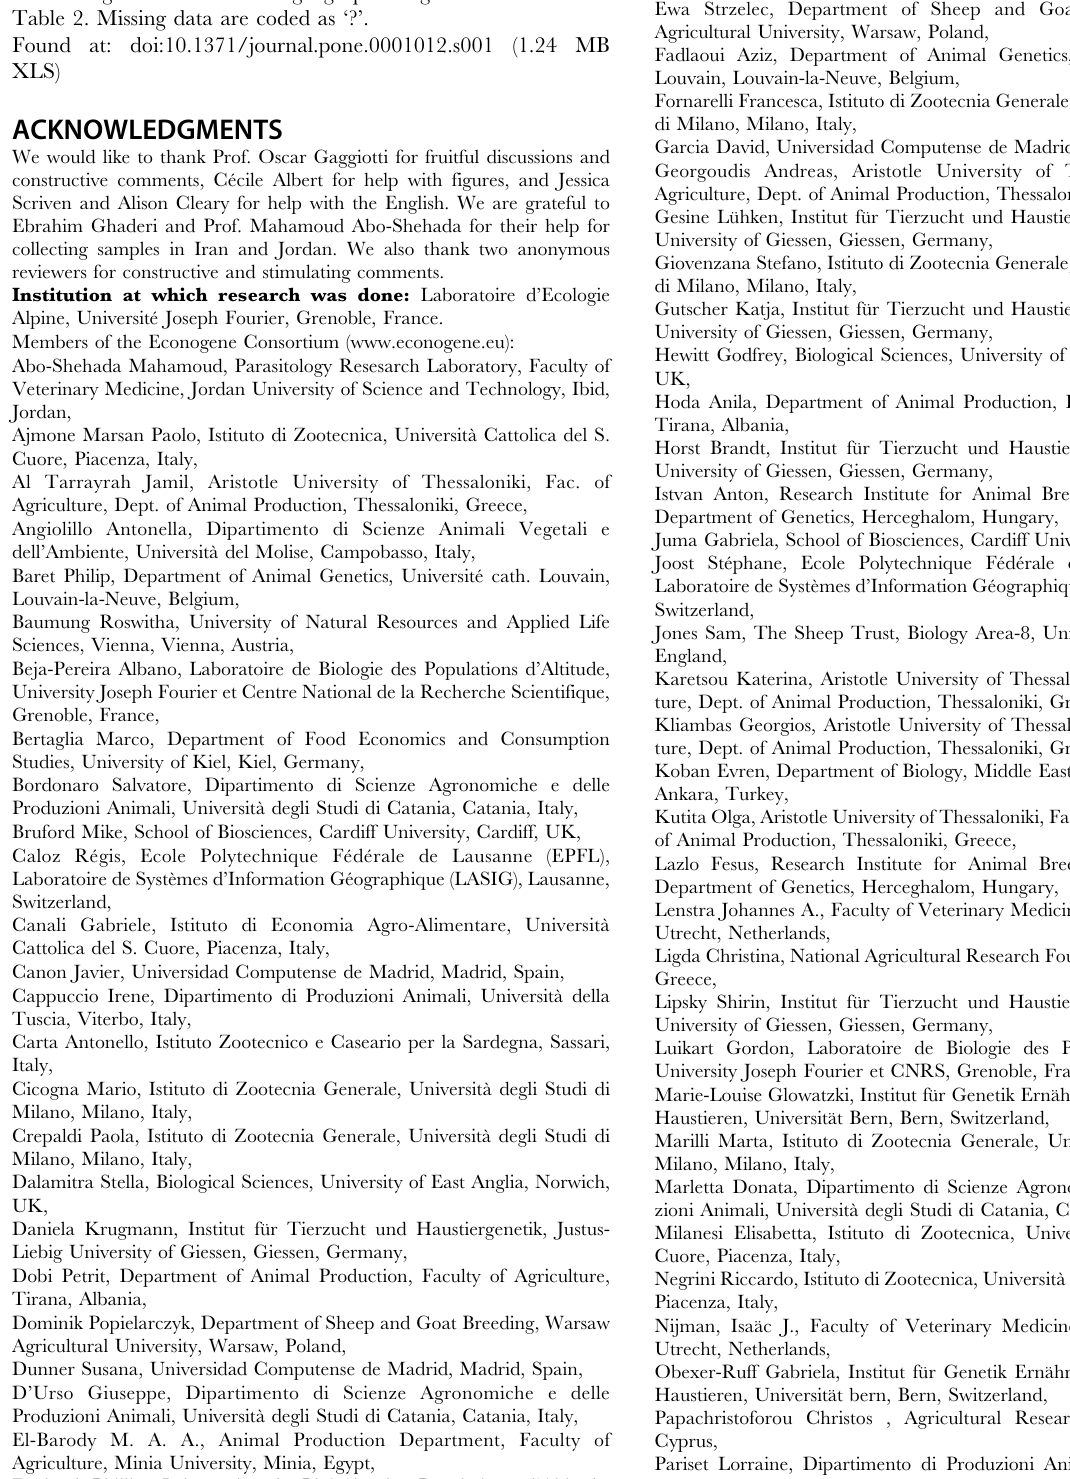
Table S1 Alignements of the 2430 control region sequences of domestic goat. The code for geographic regions are defined in Table 2. Missing data are coded as